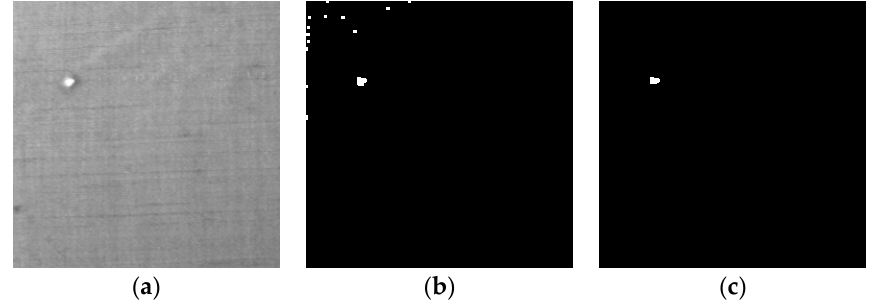
Figure 4. The comparison between methods with and without local difference analysis (LDA) module. ( a ) Original image; ( b ) The final detection result without LDA; ( c ) The final detection result with LDA.